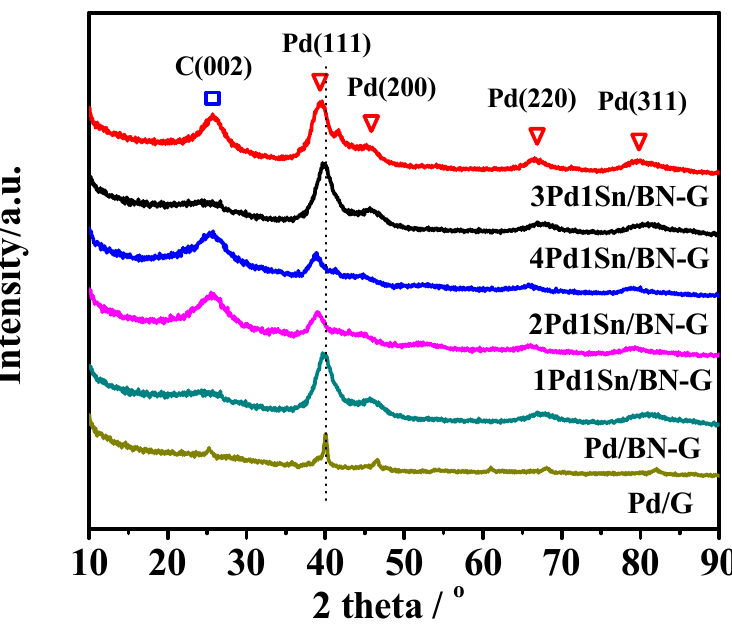
Figure 1. XRD patterns of xPdySn/BN-G, Pd/BN-G and Pd/G catalysts.